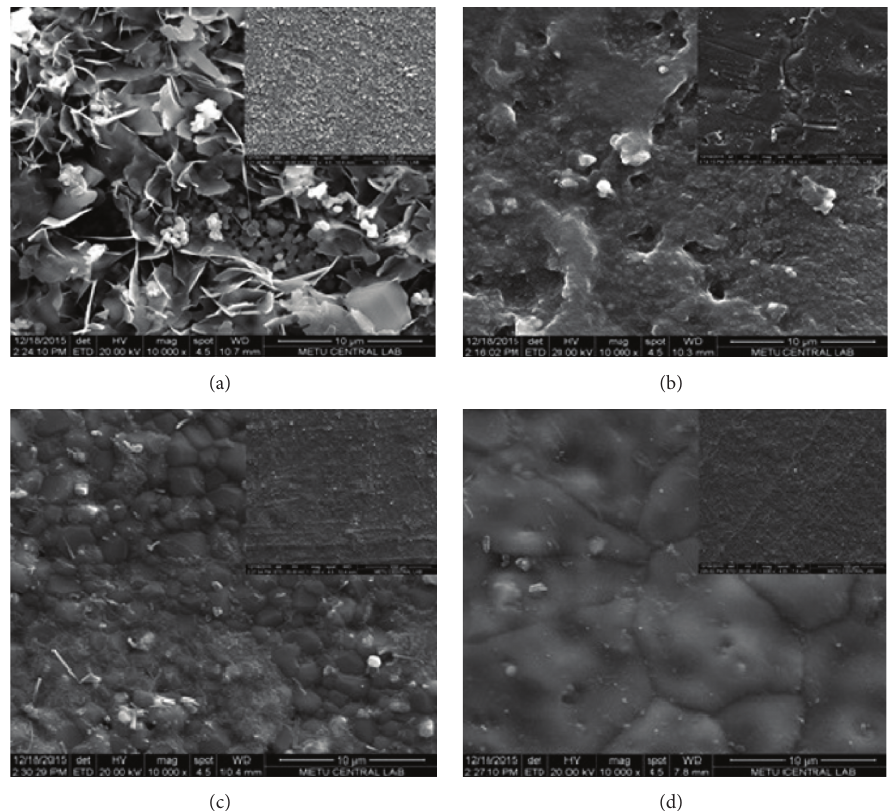
Figure 8: Microstructures of 10BHA composites sintered at (a) 1000 ∘ C, (b) 1100 ∘ C, (c) 1200 ∘ C, and (d) 1300 ∘ C at low ( × 1000, insets) and high ( × 10000, main images) magnifications.